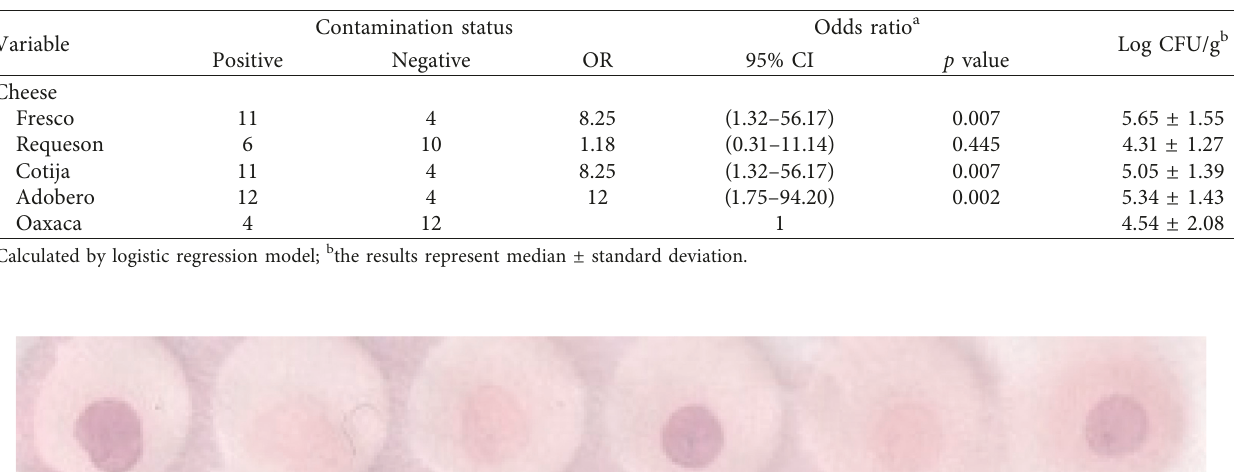
Table 2: Differential contamination by S. aureus in Mexican artisanal